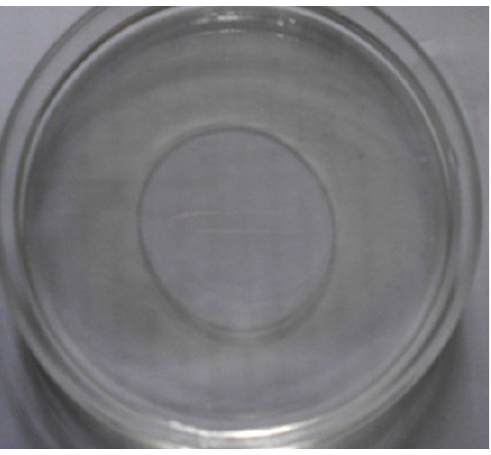
Figure 9. Oil spreading method. Positive emulsified halo. Source: [91].